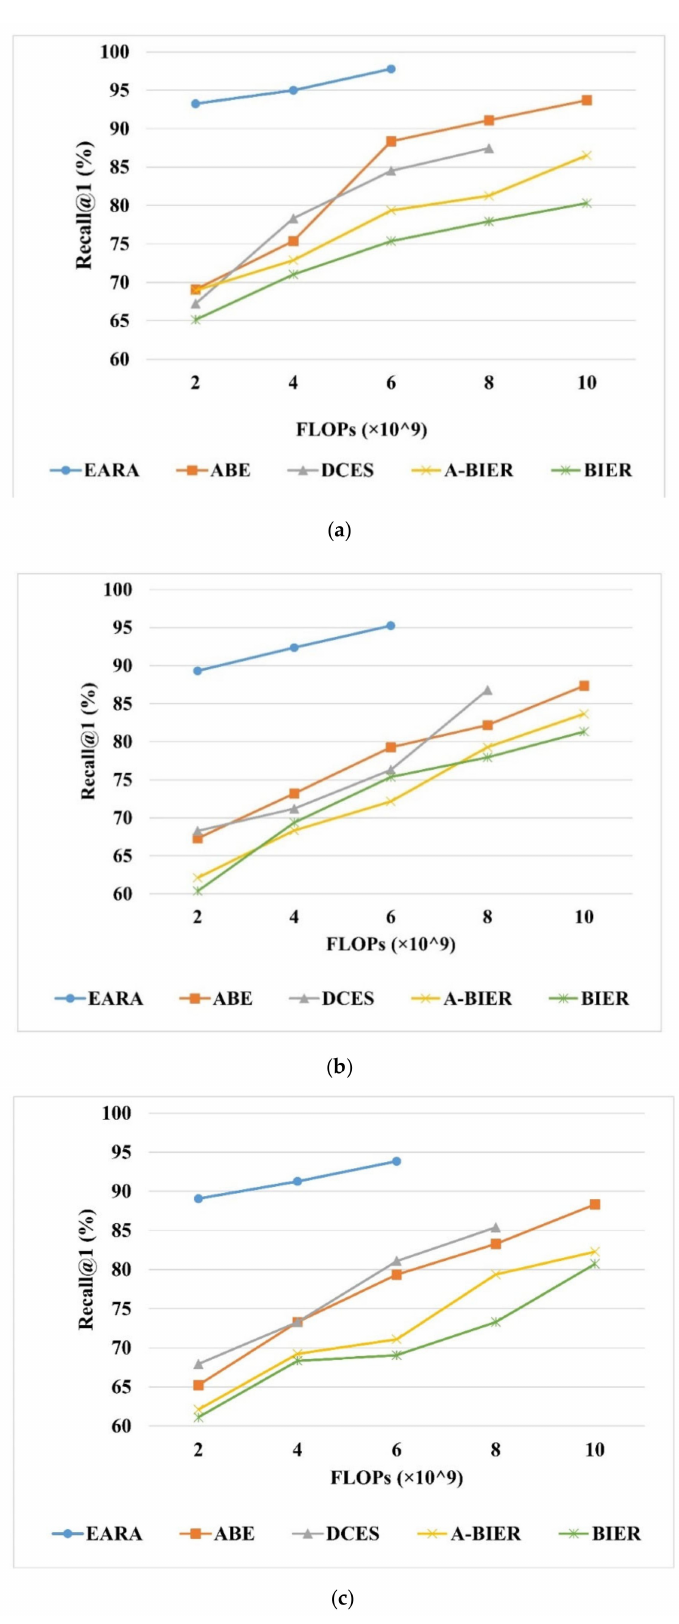
Figure 7. Comparison of the proposed architecture with BIER, A-BIER, DCES, and ABE as evaluated by Recall@1 on ( a ) UCMD, ( b ) SIRI-WHU, ( c ) and AID. The overall embedding feature is